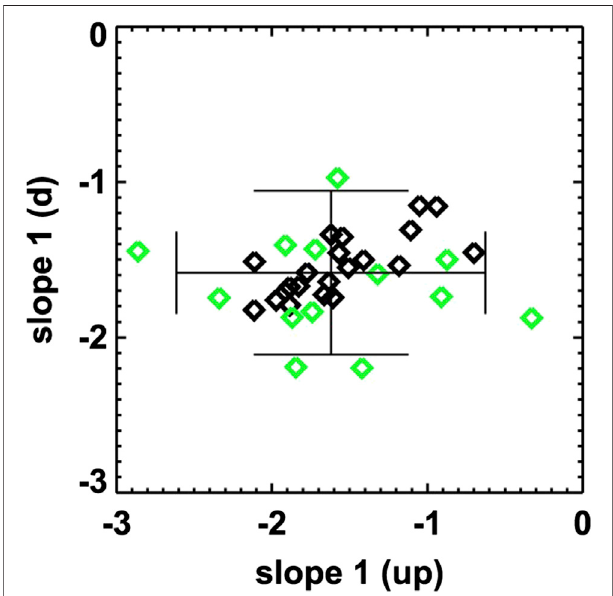
FIGURE 6 | Upstream vs. downstream spectral indices of inertial range fl uctuations of the ion fl ux for a set of 34 IP shocks of [104]. Color symbols show the reliability of estimated slopes (black denotes a more reliable estimation). The horizontal and vertical lines in the middle mark the average spectral index of slope1 in the downstream and upstream regions, respectively. The shorter horizontal and vertical lines denote 2 standard deviations from the averages of the downstream and upstream spectral indices, respectively. The plot shows that for more reliable estimated slopes, the upstream and downstream indices seem to be correlated. On the other hand, the whole set (34 cases) shows that the spread of the indices is roughly two times larger in the upstream than in the downstream region. Image adapted from [104] and reproduced by permission of the AAS.